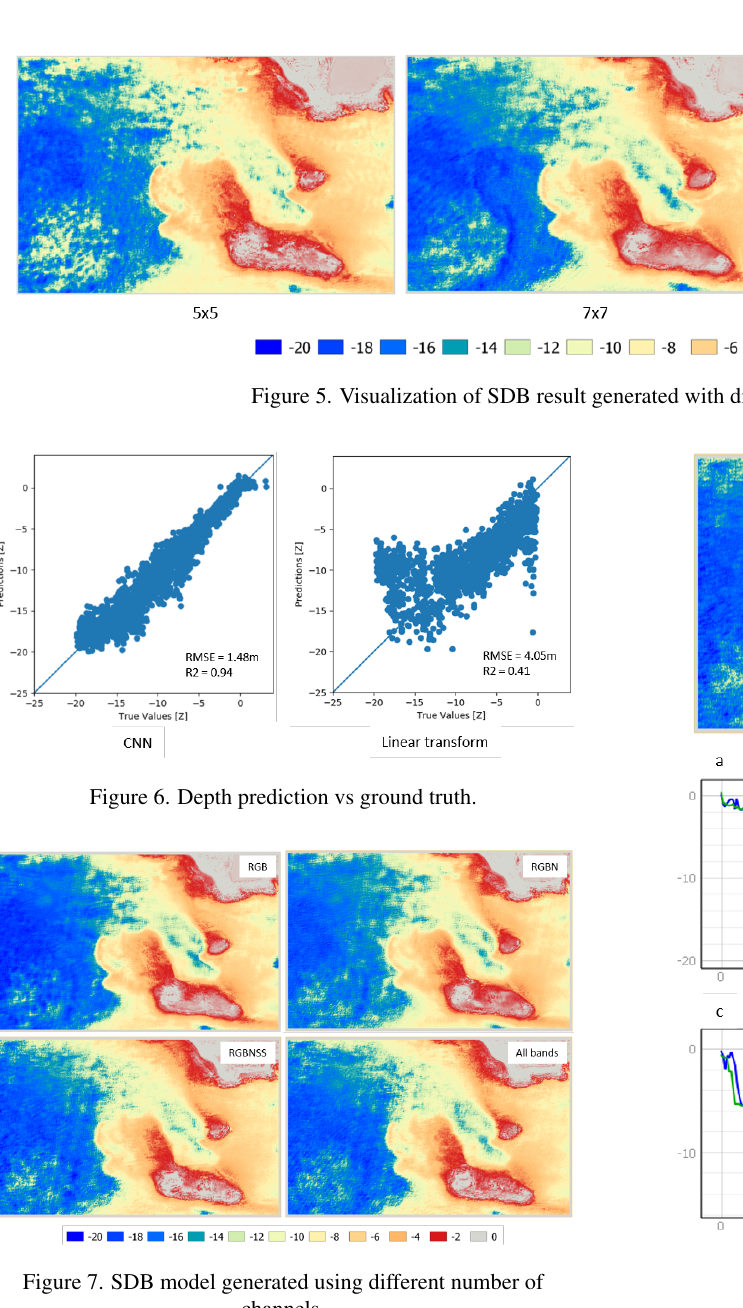
Figure 9. Cross profile showing comparison between SDB model from CNN and the in-situ measurements.